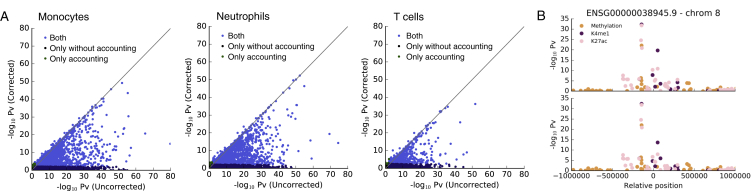
EWAS, Related to Figure 2(A) Scatterplot of the gene-level P values (see the STAR Methods) obtained from the EWAS analysis either accounting (y axis) or not (x axis) for genetic effects in all three cell types. Genes with significant cis-epigenetic association only when not accounting for underlying genetic effects (“Only without accounting,” FDR < 5%) are indicated in dark blue. Genes with significant cis-epigenetic association only when accounting for underlying genetic effects (“Only accounting”) are indicated in green. Finally, genes with significant cis-epigenetic associations both when accounting or not for underlying genetic effects (“Both”) are indicated in blue.(B) Manhattan plot for the gene MSR1 (ENSG00000038945), illustrating a cis epigenetic association that is robust to correction of genetic effects. Shown are -log10(pv) from an EWAS analysis either without accounting for cis genetic effects (top panel) or when accounting for cis genetic variation (bottom panel).